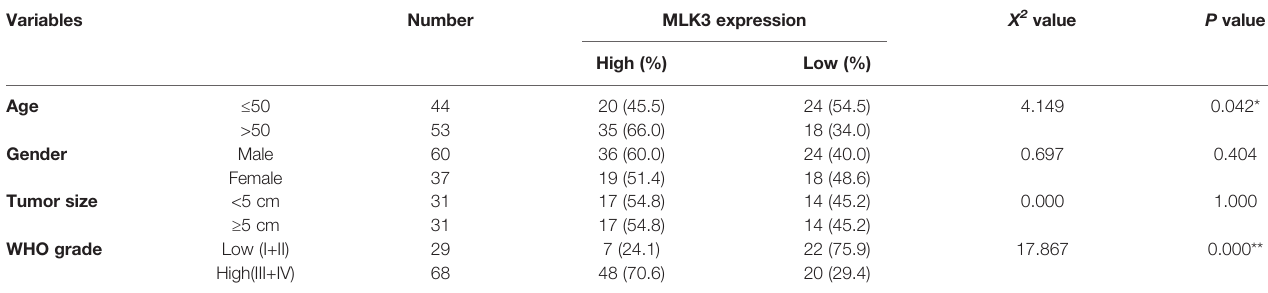
TABLE 1 | MLK3 staining and clinicopathological characteristics of 97 glioma patients.